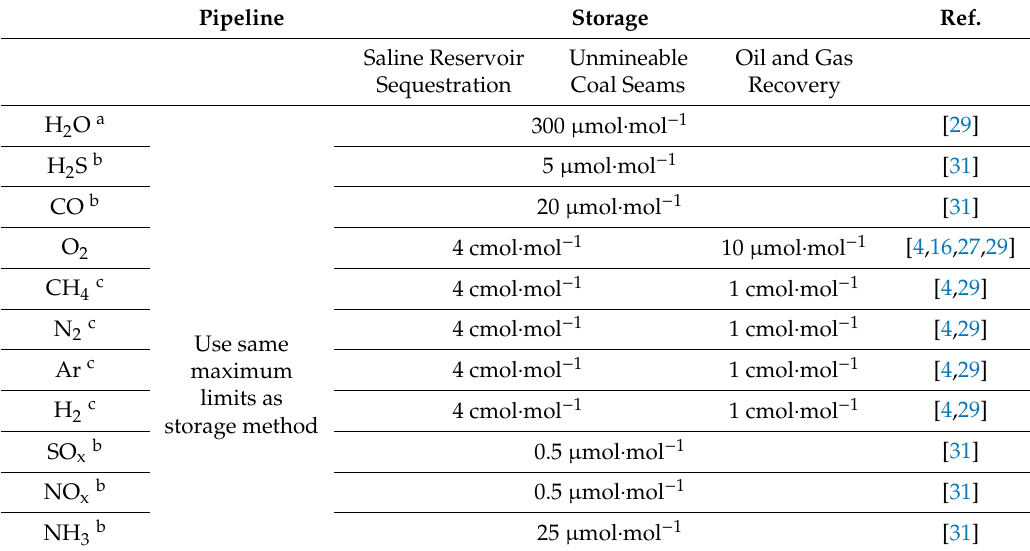
Table 5. Summary of purity